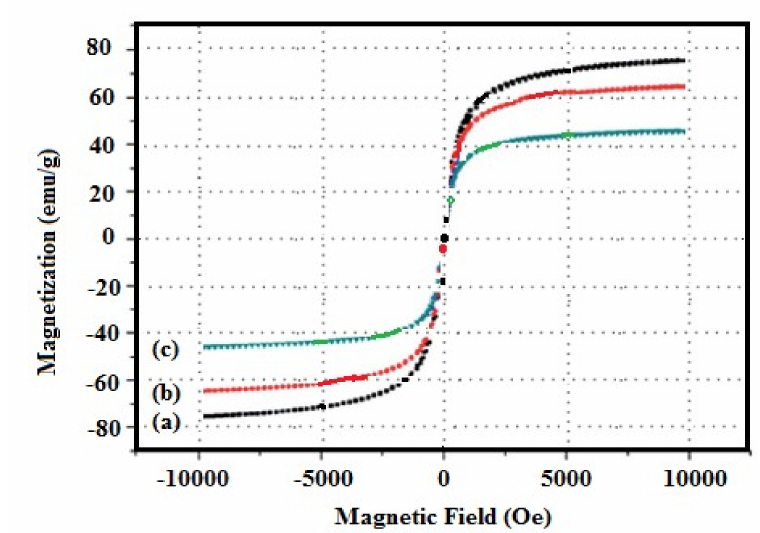
Figure 8. VSM hysteresis loops of ( a ) Fe 3 O 4 NPs; ( b ) QVP / AAm-Fe 3 O 4 ; ( c ) Fe 3 O 4 -QVP / AAm at